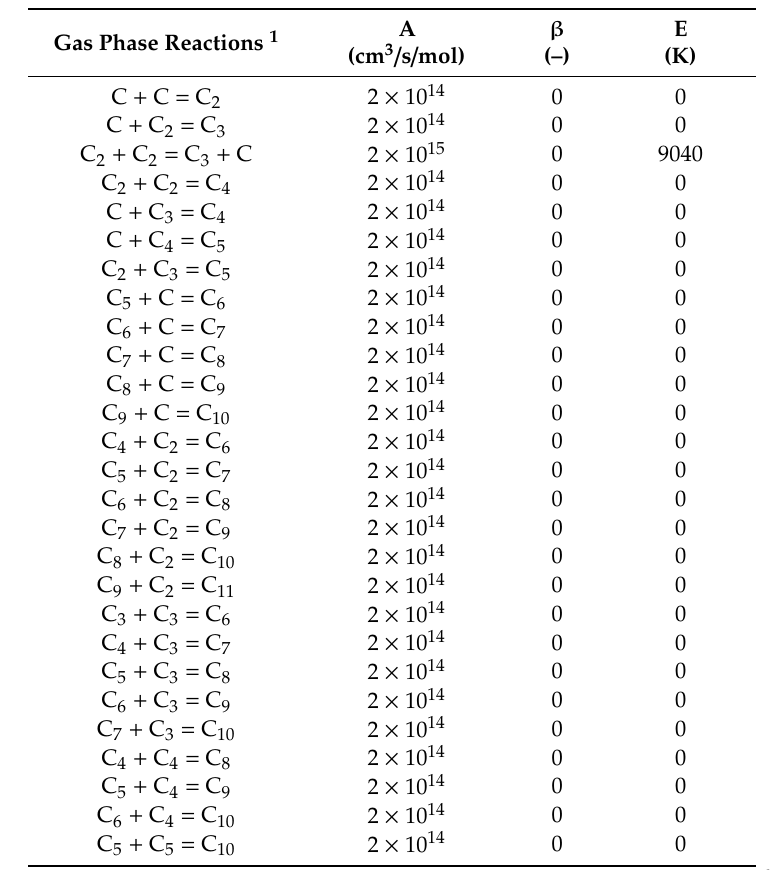
Table 4. Gas phase chemistry used for graphene